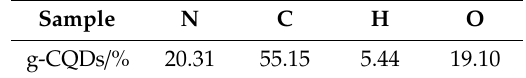
Table 3. Elemental analysis results of the g-CQDs (V (EDA) = 4 mL, T = 180 °C, D r = 12 h).